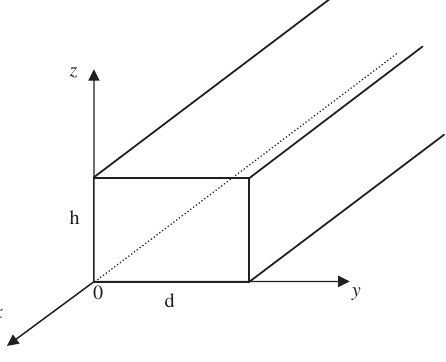
Figure 1: Schematic diagram of a bar with rectangular cross